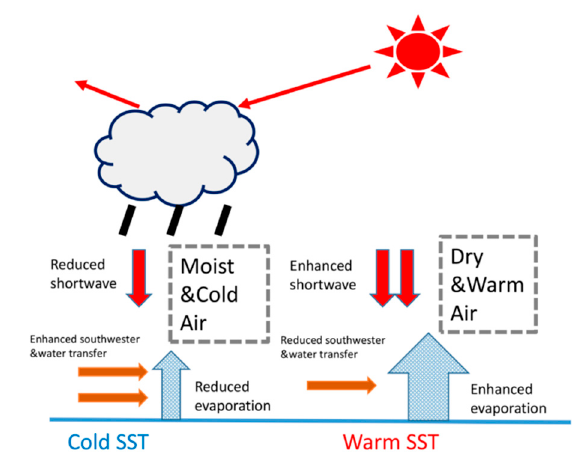
Figure 10. Schematic diagram showing the effect of BSISO on the evaporation duct over the SCS. Active convection induces decreased air–sea humidity and temperature differences, which leads to a weakened evaporation duct. For negative convection, the opposite is true.